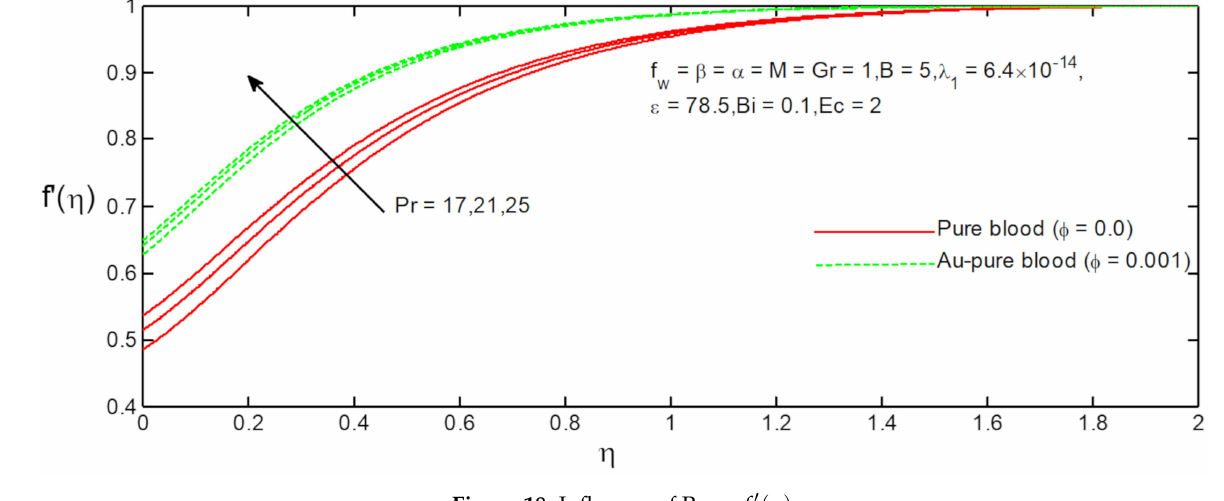
Figure 18. Influence of Pr on f (cid:48) ( η ) .